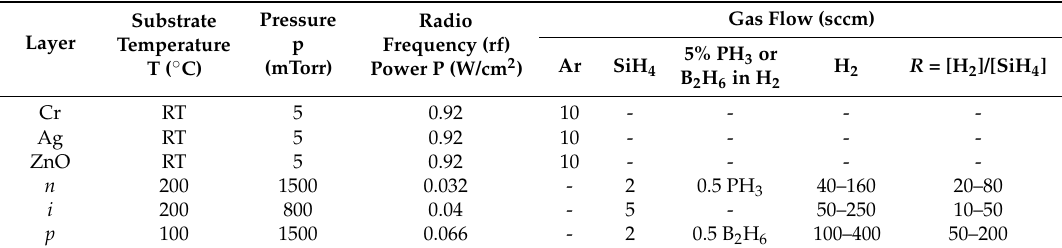
Table 1. Deposition conditions for the individual layers in the a-Si:H n - i - p solar cell configuration deposited on 6” ˆ 6” borosilicate glass substrates. The 5% dopant gas in H 2 is by volume. Cr, Ag, and ZnO were sputtered at room temperature